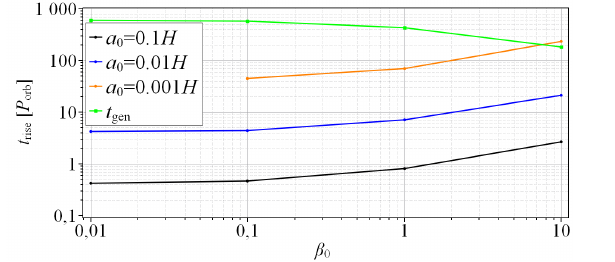
Figure 2. Dependence of the time of the MFT rise to the surface of the disk on initial plasma beta and radius of the MFT. Black line: a 0 = 0 . 1 H , blue line: a 0 = 0 . 01 H , orange line: a 0 = 0 . 001 H . Green line shows time scale of the magnetic field generation. Time is measured in rotation periods P orb